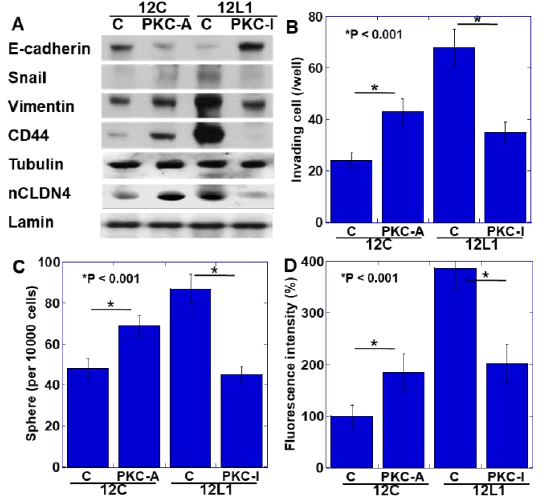
Figure 4. Effect of PKCε activity on malignant phenotypes in human renal cell carcinoma cell line. ( A ) Effect of PKC-A or PKC-I on the epithelial-mesenchymal transition (EMT) phenotype examined by immunoblotting of EMT-related proteins. ( B – D ) Effect of PKC-A or PKC-I on invasion activity ( B ), sphere-forming activity ( C ), and lung metastasis ( D ). Error bar, standard deviations calculated by ordinary analysis of variance from 3 independent examinations. 12C, SN12C; 12L1, SN12L1; CDH1, E-cadherin; nCLDN4, nuclear CLDN4; C, untreated control; PKC-A, PKCε activator; PKC-I, PKCε inhibitor peptide.